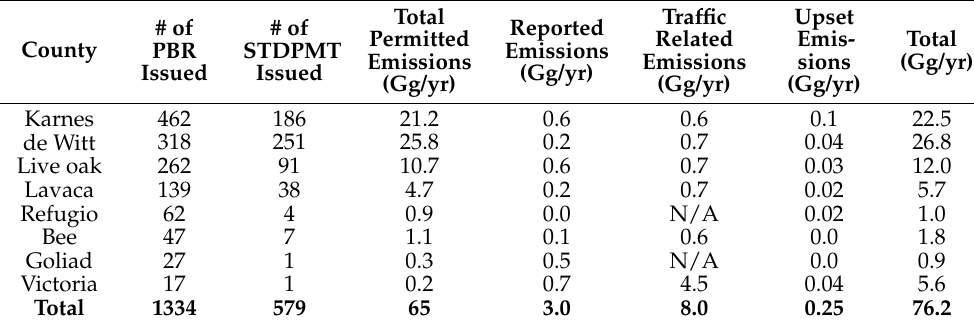
Figure 1. Per county volatile organic compound (VOC) emission allowances in Gg per year compared to an example area of the atmospheric calculations from our prior study (30 July 2014) [8]. The hatched area encloses the origin of 90% of the emissions that occurred over the prior 12 h impacting the monitor that afternoon; the light blue area approximates the respective total marginal impact area over that time frame. Table 1. County contributions to the permitted, reported, traffic related, and upset emissions. PBR: Permit by Rule, and STDPMT: standard